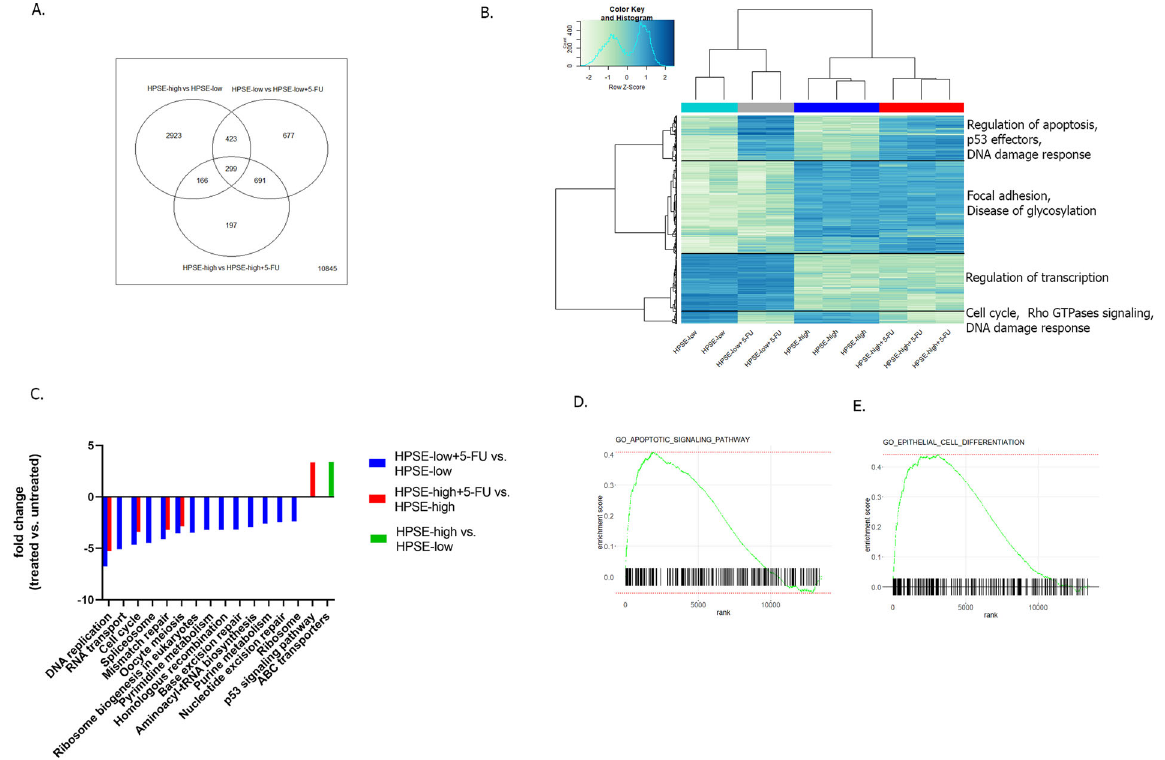
Fig. 3 Gene-expression pro fi le in HPSE-high MCF7 cells following treatment with 5-FU. A Venn diagram showing overlap of gene- expression differences associated with 5-FU treatment in HPSE-high compared with HPSE-low MCF7 cells. B Heat map and hierarchical clustering of the overall transcriptome differences. Gene set enrichment analysis detected differentially expressed pathways (FDR < 0.05) following treatment with 5-FU in HPSE-high and HPSE-low control cells, such as regulation of apoptosis, DNA damage response, and cell cycle ( C ) A gene set enrichment analysis. D , E Gene Set Enrichment Analysis (GSEA) enrichment plot involved in apoptosis ( D ) and epithelial cell differentiation ( E )